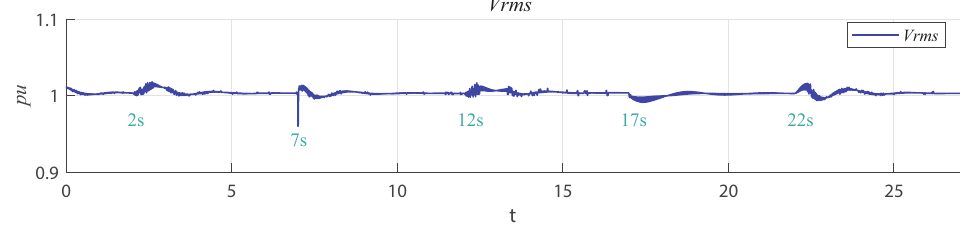
Figure 15. RMS voltage in per unit for case study